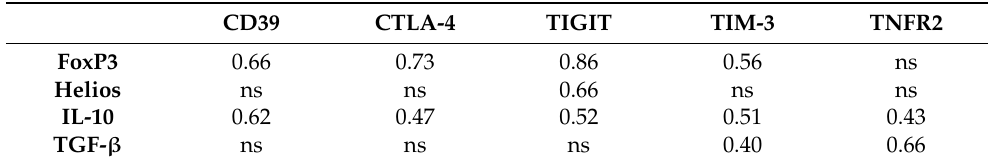
Table 1. Correlation (R) between normalized mRNA expression of surface Treg markers and that of Treg phenotypic/functional genes.